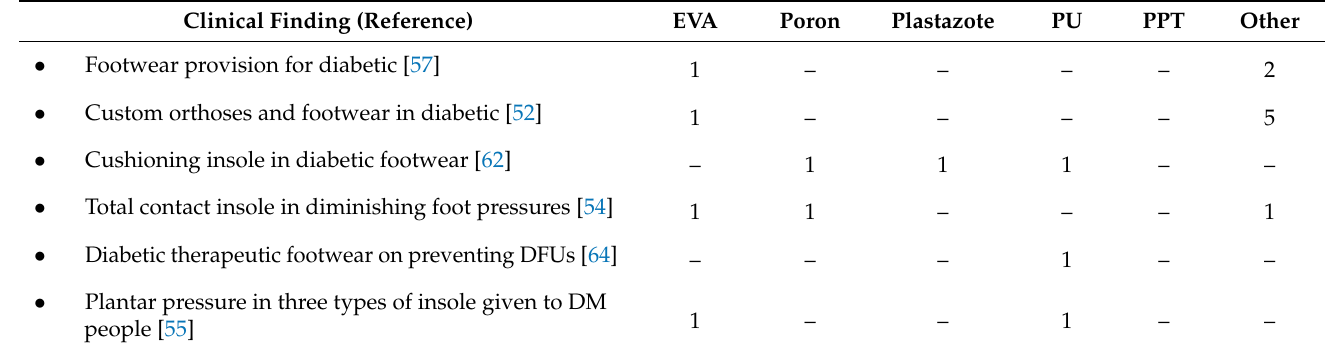
Table 3. The published paper discussed selected insole materials on the midfoot region. Clinical Finding